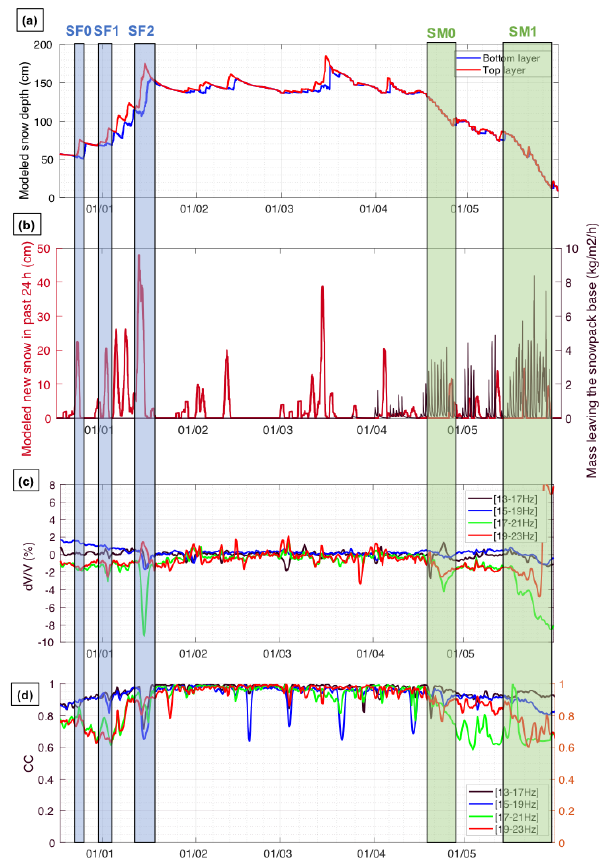
Figure 4. Results of snow simulations over the entire season from December 2018 and June 2019, with (a) interpolated snow depth of layers defined by a procedure based on density and (b) modeled new snow in the past 24h (in red) and mass leaving the snowpack base, highlighting melting in spring (black curve). Seismic observations are also presented over the same period, with relative surface wave velocity changes (d V/V ) (c) and the correlation coefficient (CC) (d) for different frequency bands (see legend). From these time se- ries, we select three snowfall events (SF0, SF1 and SF2 in blue boxes) and two melting periods (SM0 and SM1 in green boxes), during which a significant and simultaneous d V/V response oc- curs.